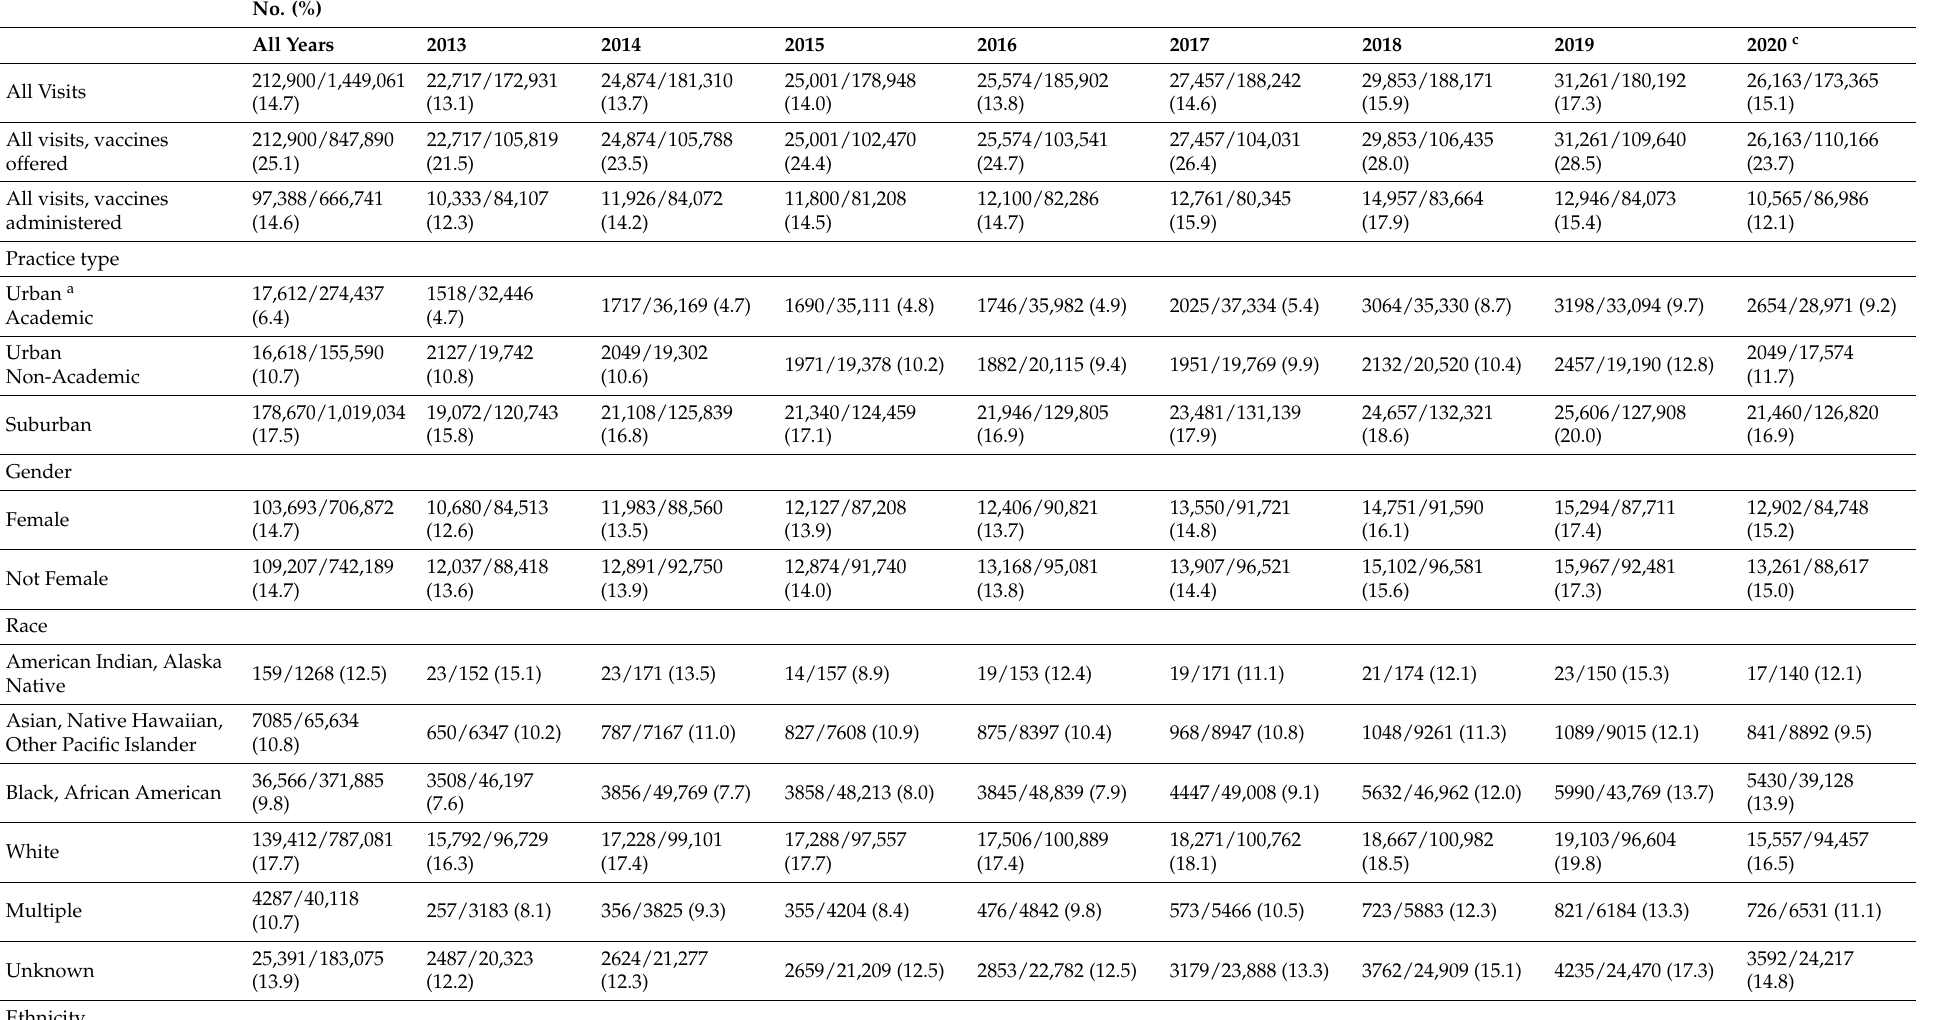
Table 2. Demographics and Markers of Vaccine Refusal of Annualized Preventive Patient-Year Visits in the Study Cohort, 2013–2020 (N =